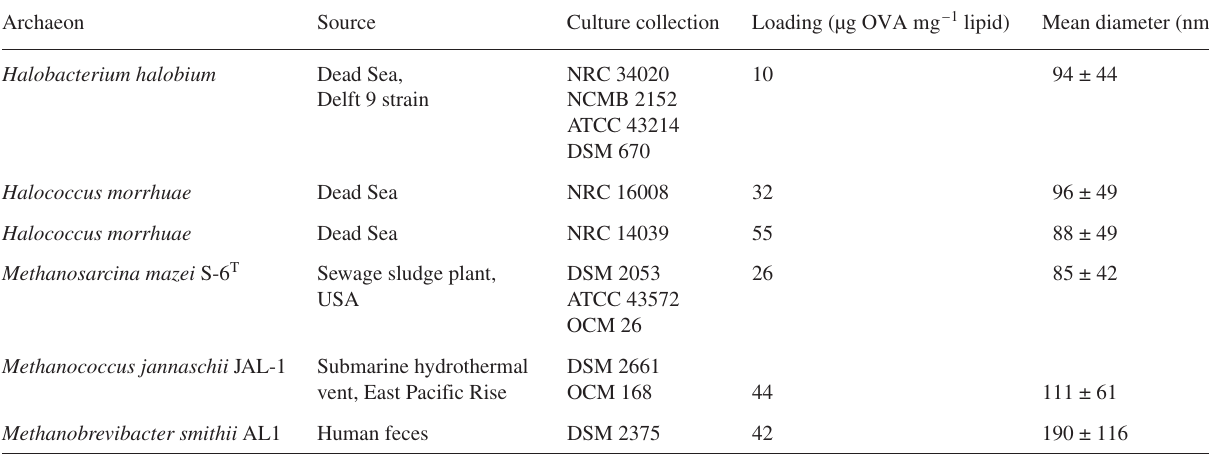
Table 1. Sources of archaea and characteristics of their total polar lipid, ovalbumin (OVA)-loaded archaeosomes. Abbreviations of culture collec- tions: NRC = National Research Council Canada; NCMB = National Collection of Marine Bacteria; ATCC = American Type Culture Collection; DSM = Deutsche Sammlung von Mikroorganismen und Zellkulturen; and OCM = Oregon Collection of Methanogens. Loading of OVA in ar- chaeosomes used in this study and archaeosome size characteristics are